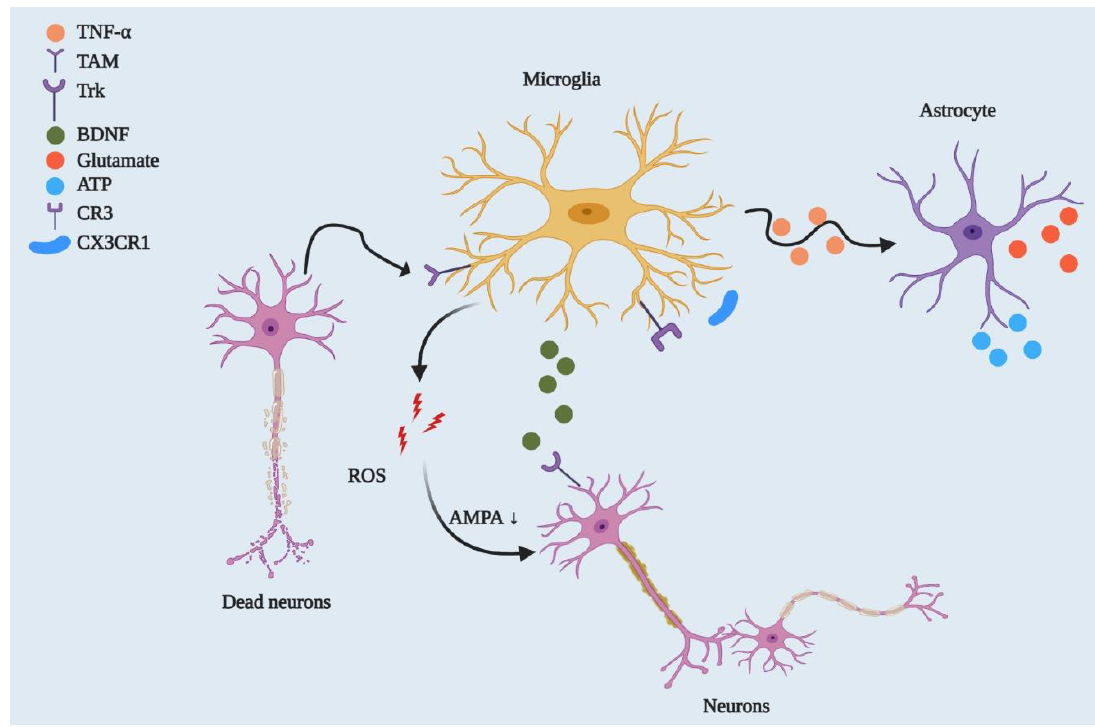
Figure 2. Microglial regulation of neuronal networks and CNS homeostasis. By playing a phagocytic role, microglia engulf dead or degenerated neurons via TAM receptor-mediated recognition of GAS6-opsonised cells. Microglia control synaptic plasticity by downregulating AMPA receptor activity through ROS secretion and by modulating BDNF/Trk receptor path- ways. Beyond this, microglia can strip synapses through Cx3cr1-Cx3cl1 interactions and microglial major histocompatibility complex II (MHCII) [32]. They can also affect neuronal circuitry via interacting with astrocytes through the TNF-mediated pathway, which releases glutamate and ATP from astrocytes.